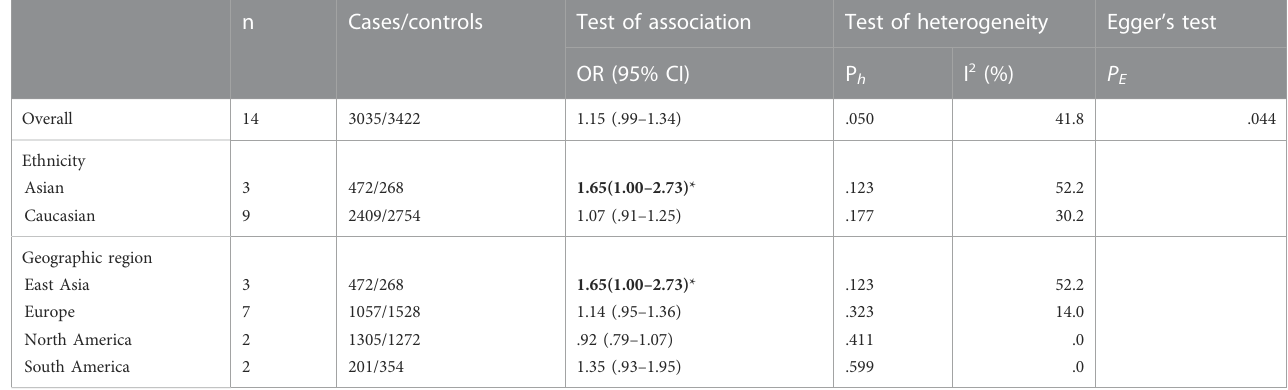
TABLE 6 Pooled estimates of the association of GSTM1 polymorphism with risk of ovarian cancer.